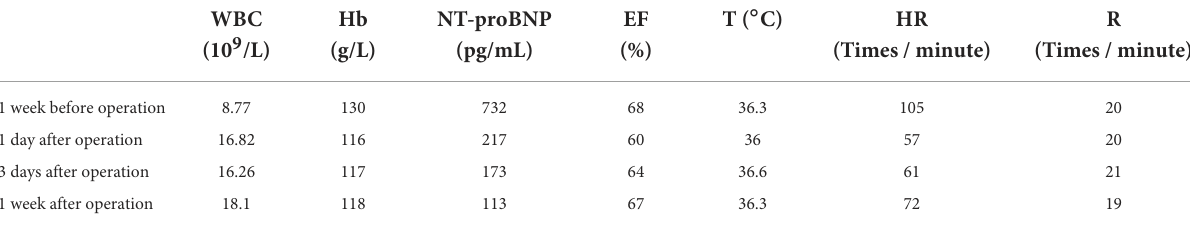
TABLE 1 Several laboratory data cases showing the change in leukocytosis and vital